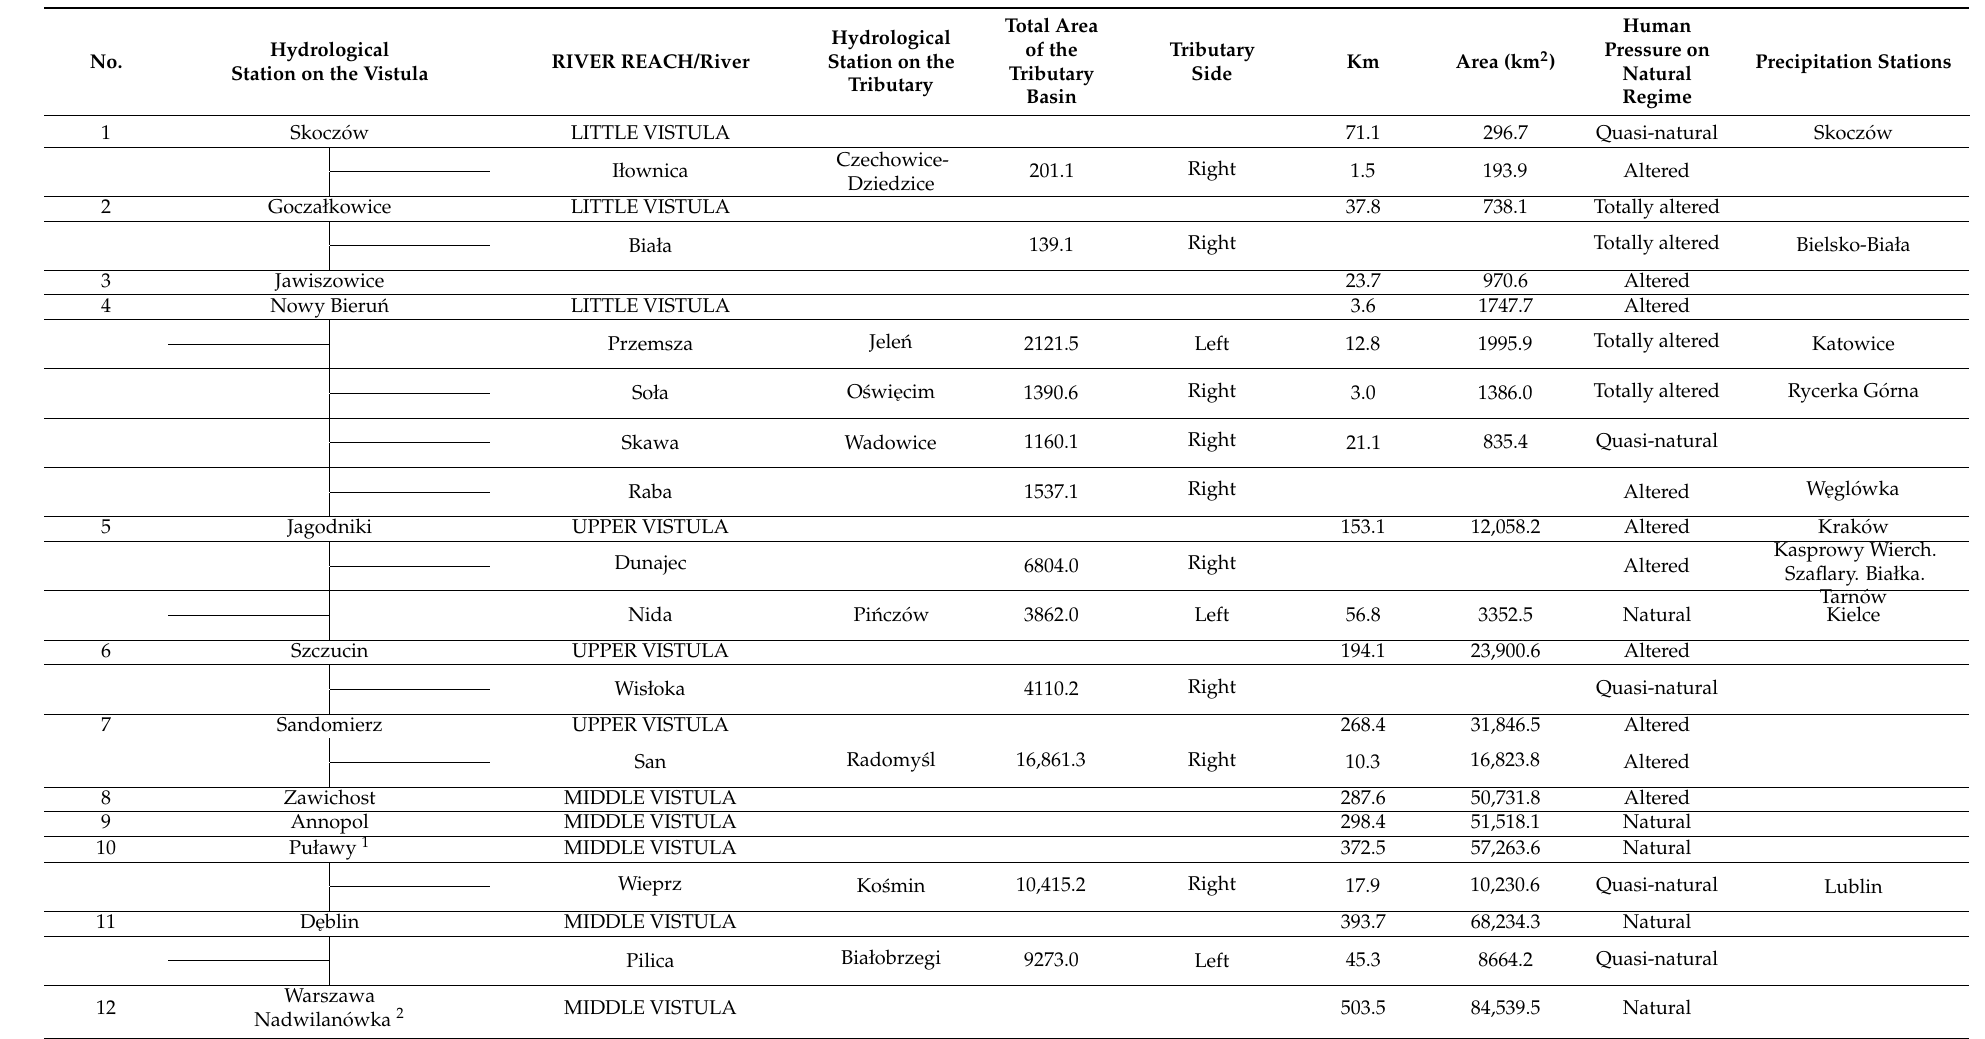
Table 3. Hydrological stations in the Vistula basin used in the research on the background of simplified schematic hydrographical network structures.